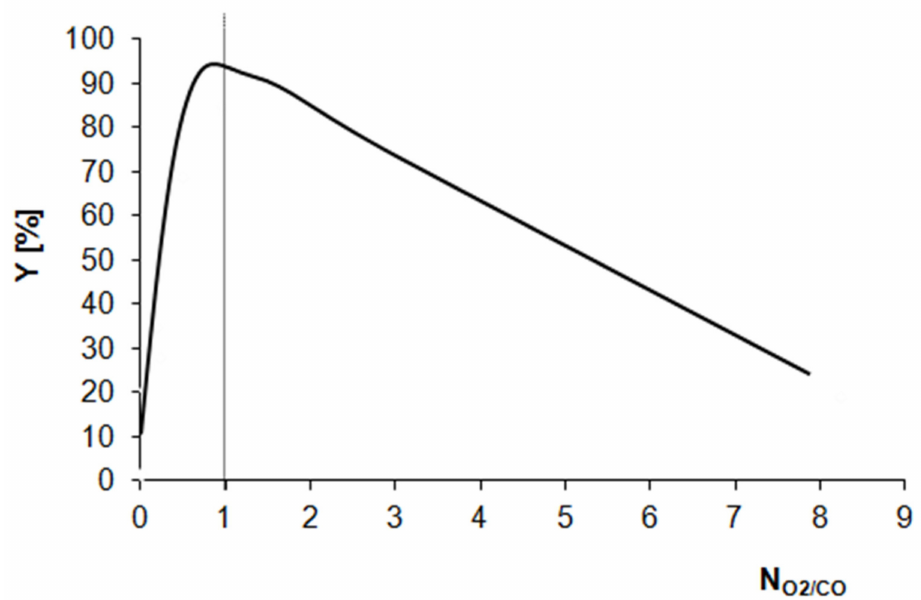
Figure 6. The CO conversion yields (Y) as a function of the ratio of the concentration of O 2 adsorption sites to the concentration of CO adsorption sites (NO 2